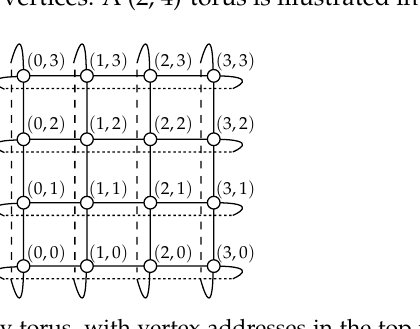
Figure 1. A two-dimensional four-ary torus, with vertex addresses in the top right-hand corner of each vertex